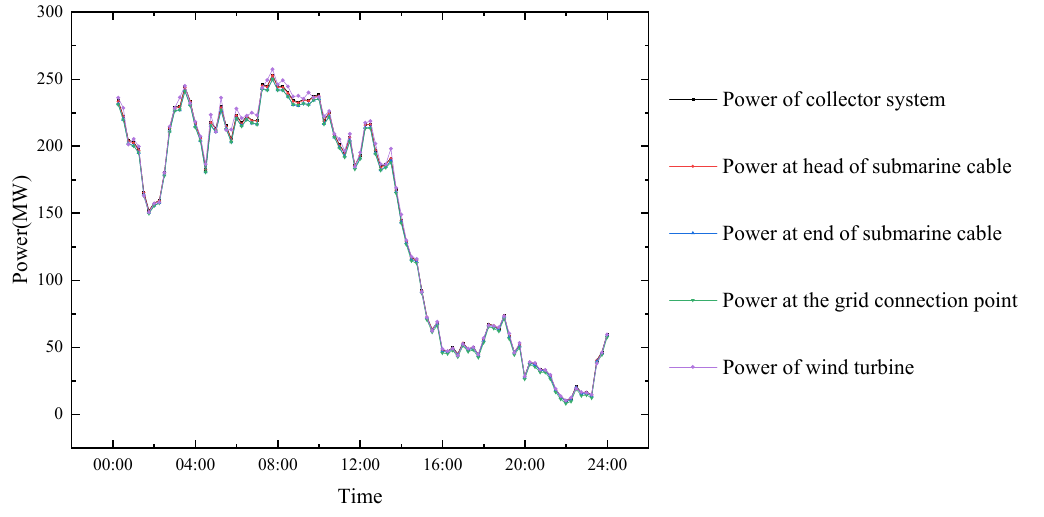
Figure 7. Power curve of offshore wind farm.